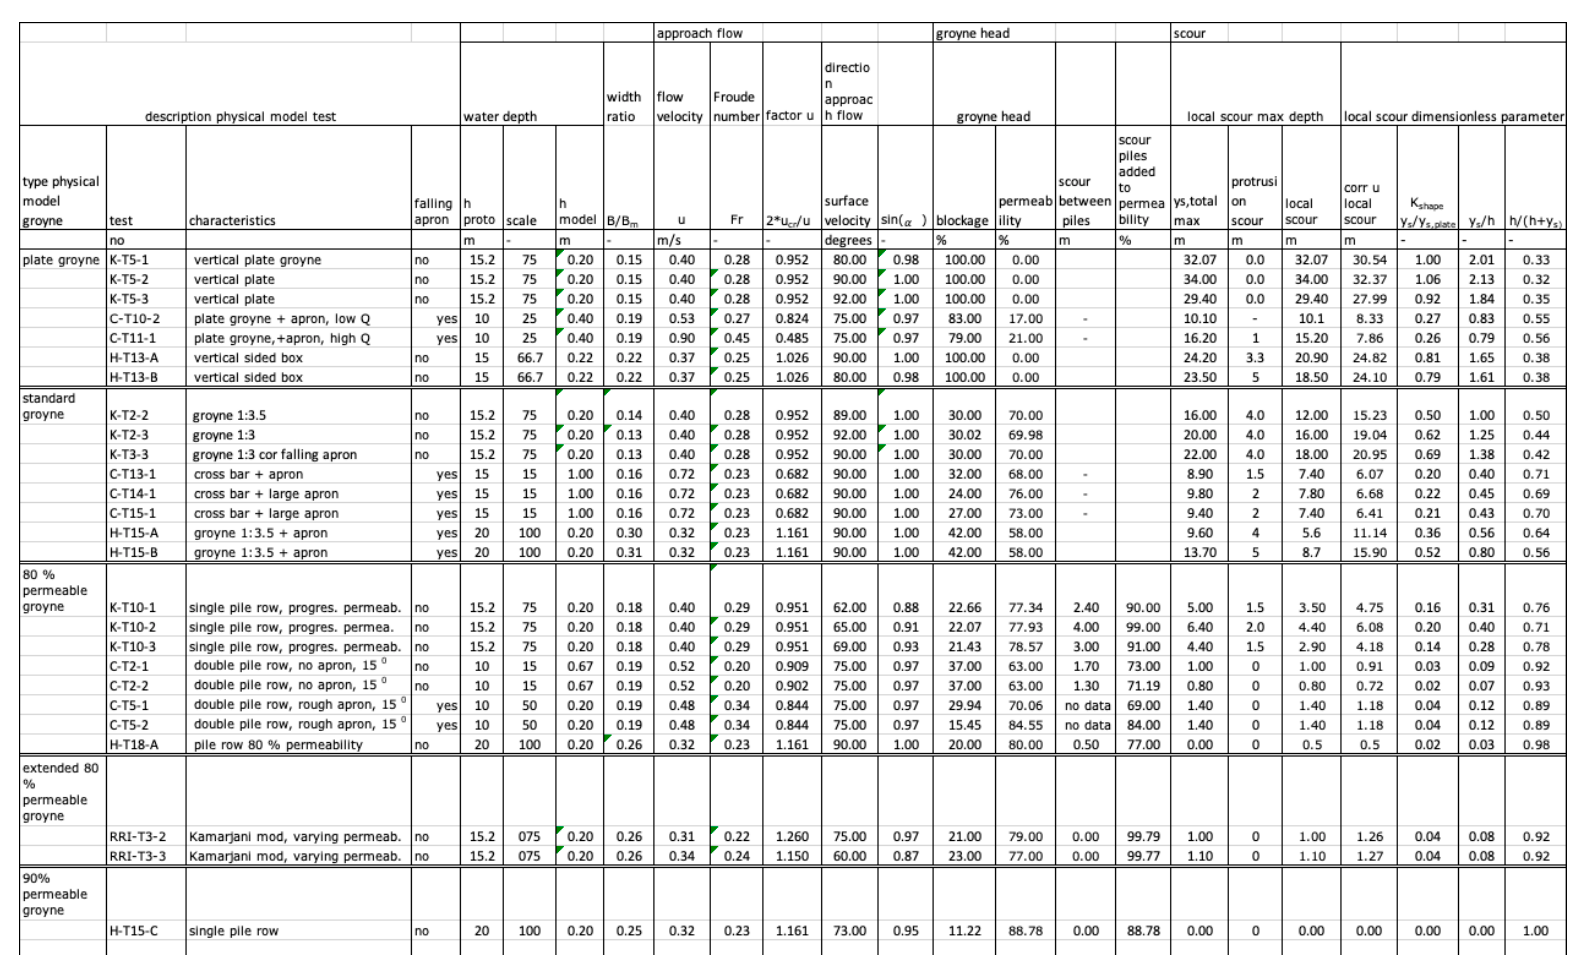
Figure A1. Data of tests in three physical model investigations. The definition of not mentioned symbols in Figure A1: α = angle between the main direction of the approach flow and axis of a groyne (degrees); y s,total,max = maximum depth in local scour hole as sum of protrusion scour and the local scour (m).